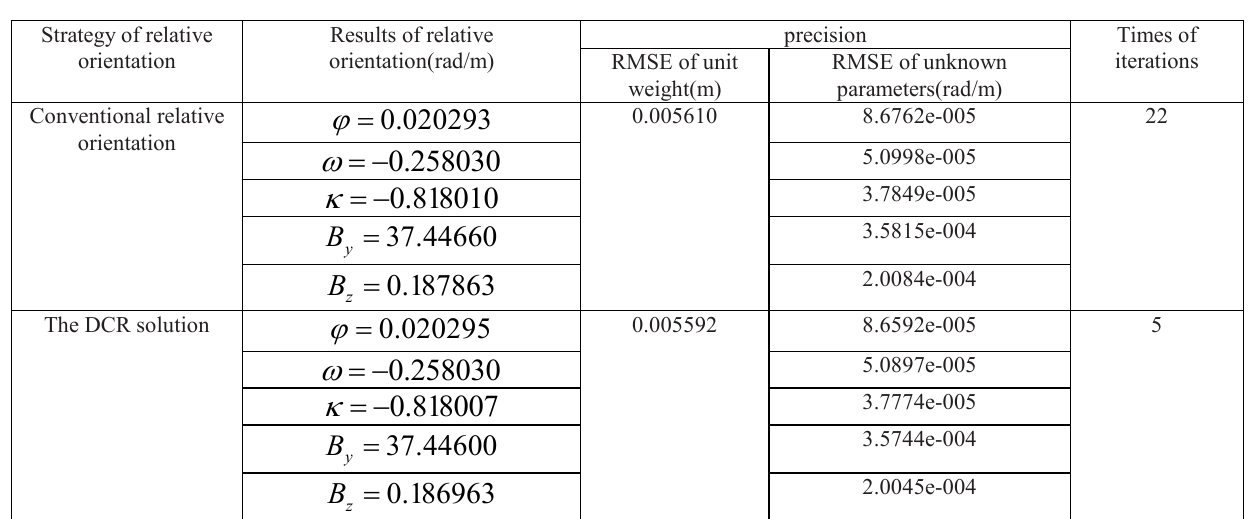
Table 1. Results of relative orientation obtained by the first experiment data with different approaches.